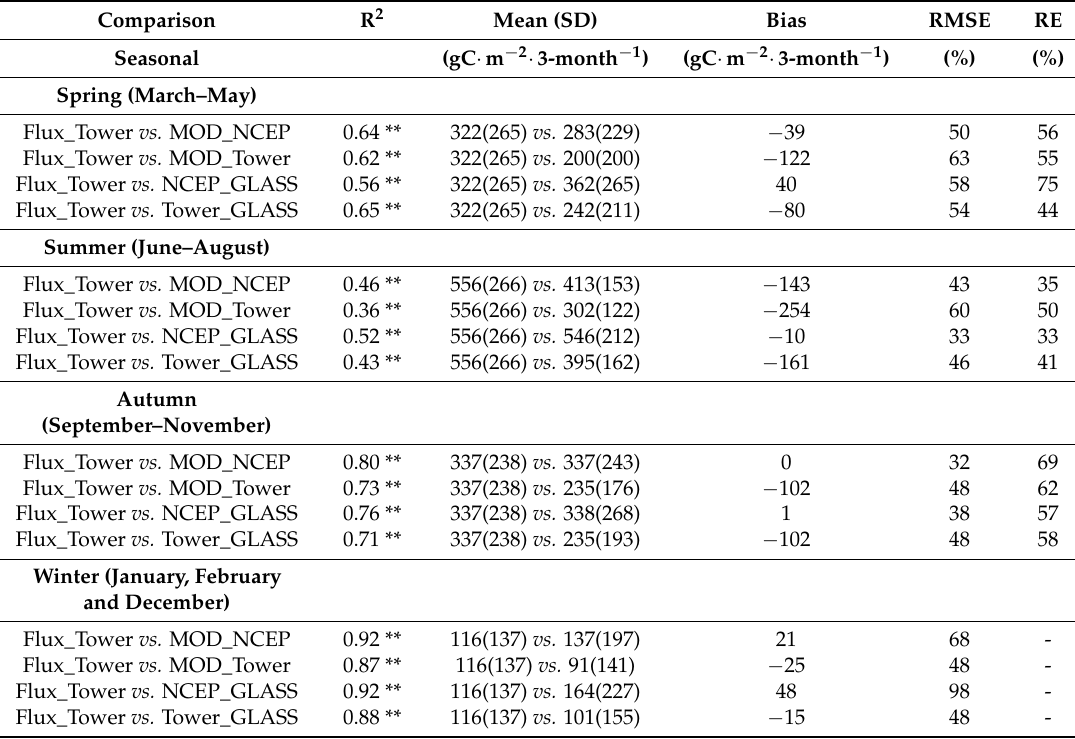
Figure 7. Comparisons of Flux_Tower GPP for winter (January, February and December) with: ( a ) MOD_NCEP GPP; ( b ) MOD_Tower GPP; ( c ) NCEP_GLASS GPP; and ( d ) Tower_GLASS GPP. Significance levels: ** p < 0.01. Table 3. Comparison of the seasonal and annual GPP derived from the tower estimates with those derived from the MODIS algorithms (MOD_NCEP GPP, MOD_Tower GPP, NCEP_GLASS GPP, and Tower_GLASS GPP).